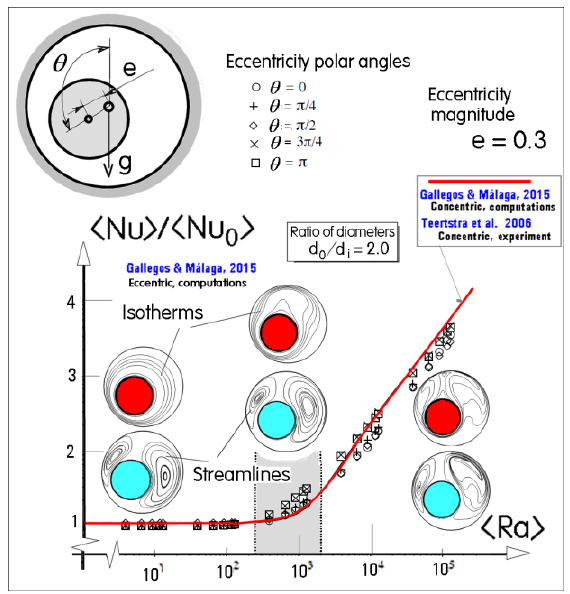
Fig. 12. Computations adapted from ref. [ ] of velocity and temperature fields between two spheres in the eccentric configurations. In the cases of interest for the present article the polar angle between eccentricity e and the graviational acceleration (Fig. 6) is solely  . At any rate, these results demonstrate that the deviations from the concentric case Fig. 9 are rather small. .